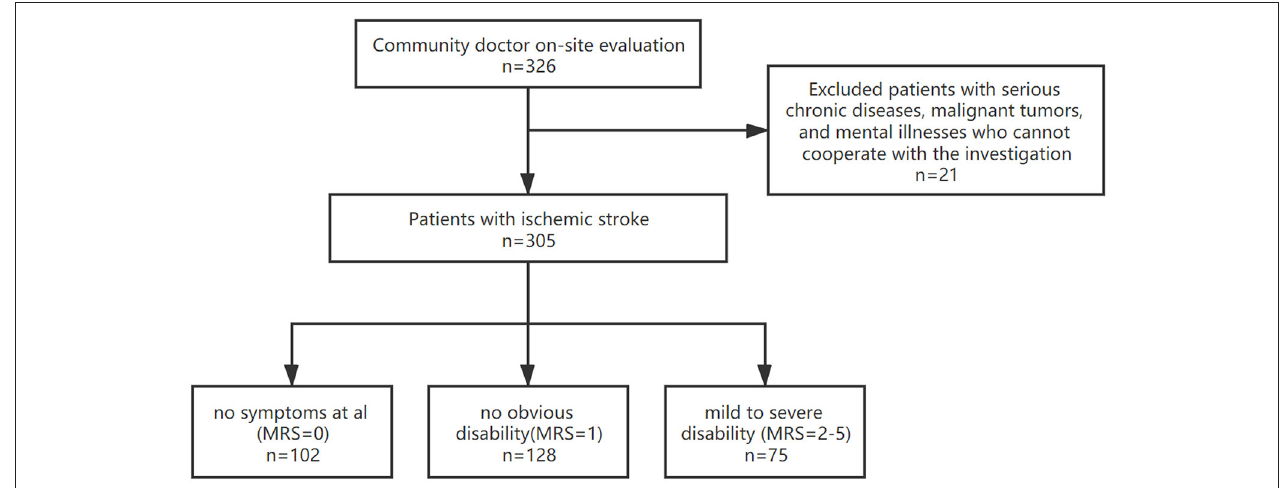
FIGURE 1 | Flow chart of the cross-sectional study among ischemic stroke patients. myocardial infarction history; stroke patients with higher ESRS scores are at a higher risk of stroke recurrence